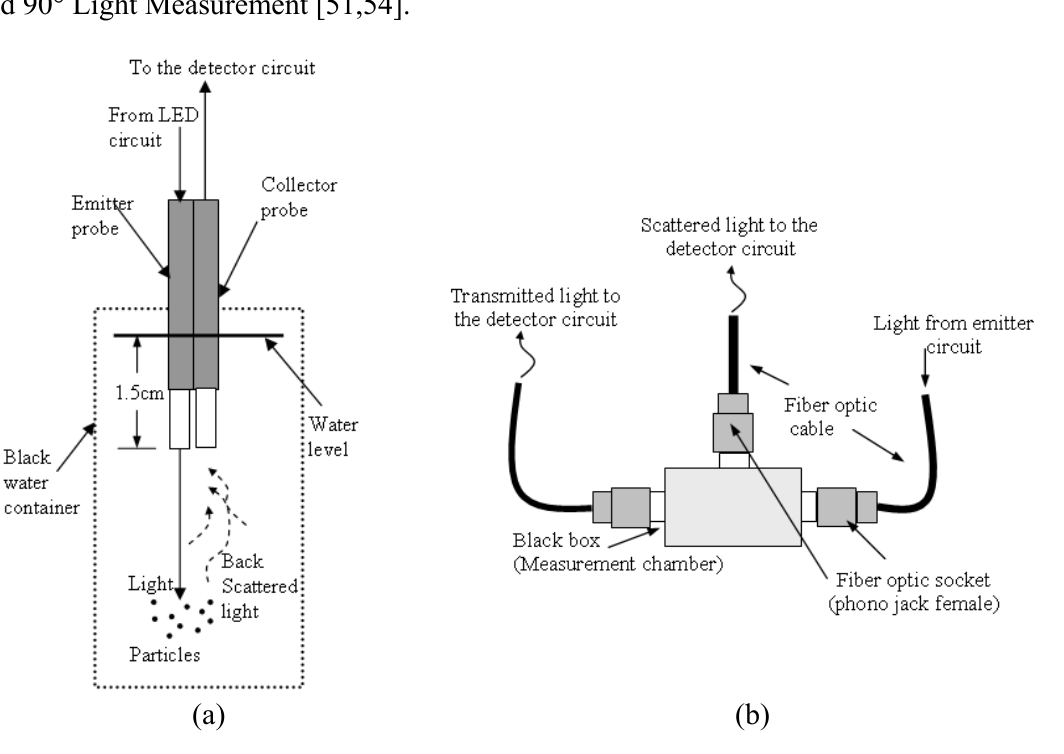
Figure 10. Experiment Setup for (a) Backscattered Light Measurement (b) Transmittance and 90° Light Measurement